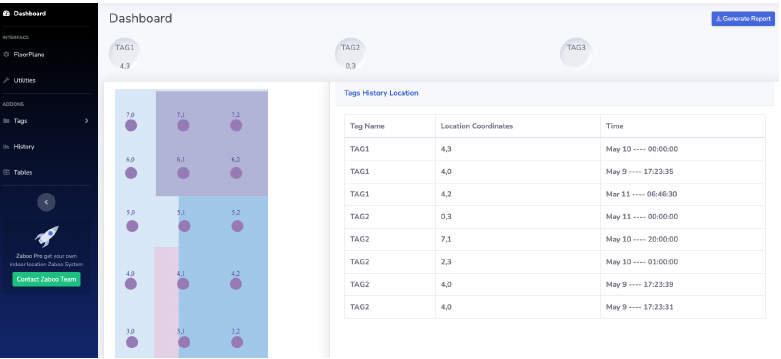
Figure 13. Frontend interface used to present the current location and previous locations of the